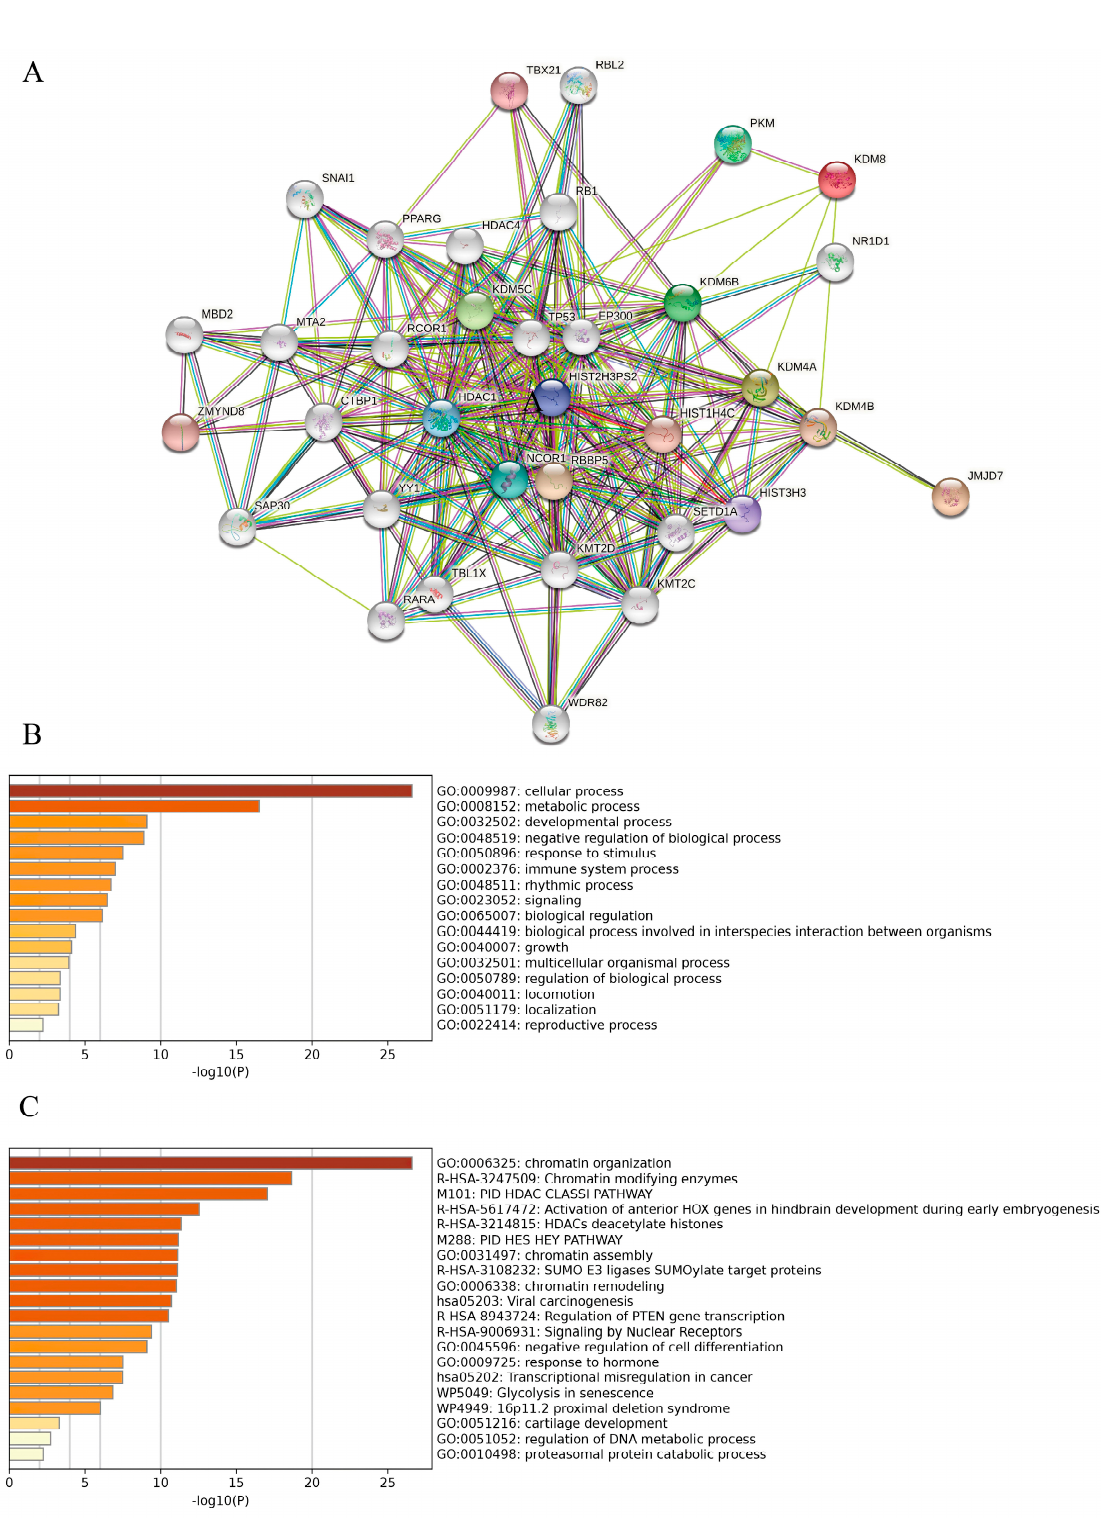
Figure 8. The PPI network of identified HDM genes and Gene Ontology (GO) analysis and pathway and process enrichment analysis of interacting proteins using Metascape. ( A ) PPI network of five HDMs. ( B ) GO biological processes analysis of interacting proteins. ( C ) Pathway and process enrichment analysis of the top 20 clusters. Abbreviations: PPI, protein–protein interaction; HDM, histone